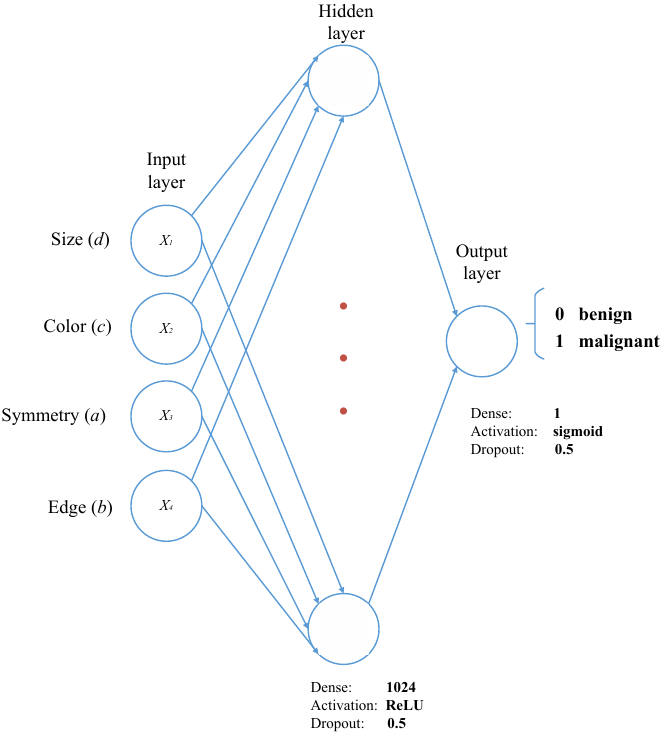
Figure 7. Proposed multilayer perceptron, four input data, and one output data. Table 2. Accuracy obtained using different MLP (Multilayer Perceptron)